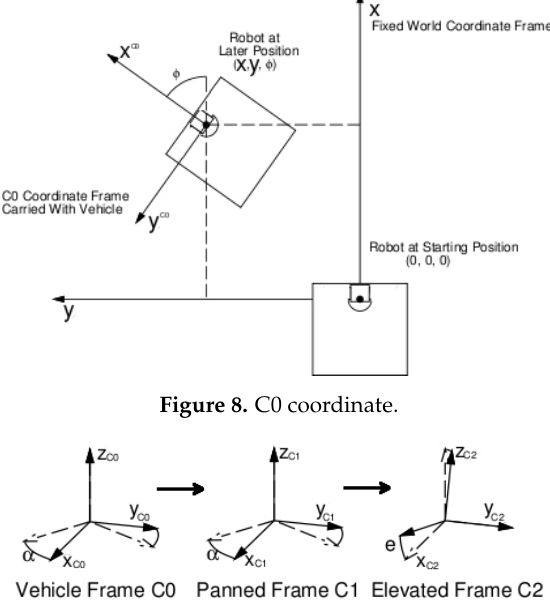
Figure 8. C0 coordinate.